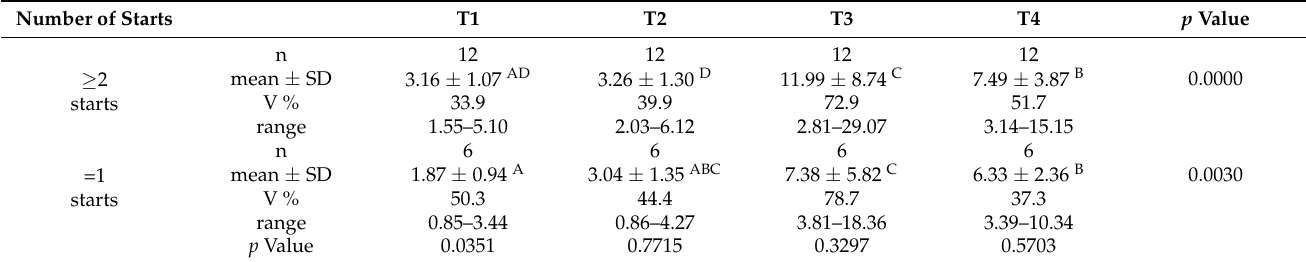
Table 3. Cortisol levels in Hucul mare saliva (ng/mL) relative to their number of starts in the qualification